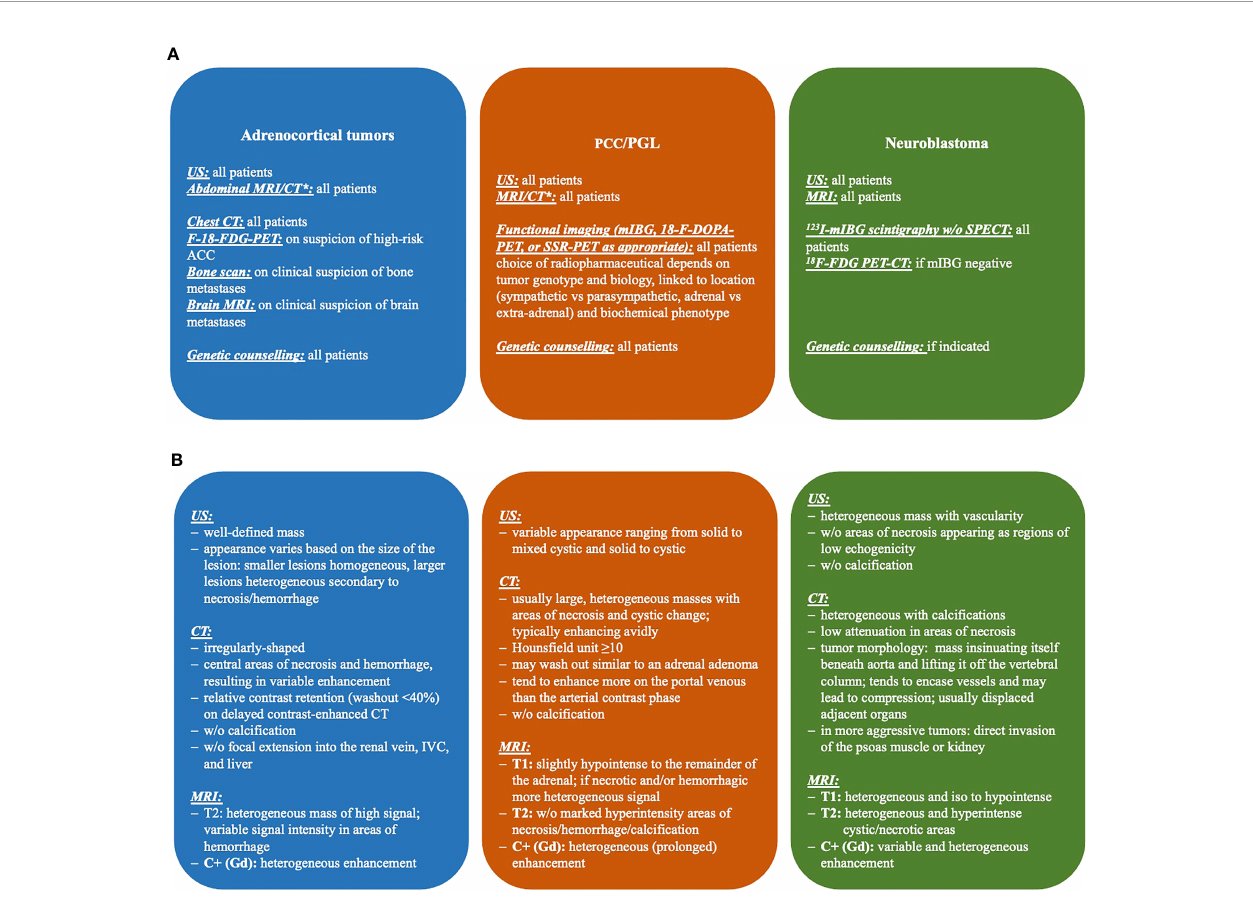
FIGURE 1 | Imaging diagnostics (A) and features (B) of adrenal tumors in children. CT, computed tomography; FDG, fl uorodeoxyglucose; mIBG, metaiodobenzylguanidine; MRI, magnetic resonance imaging; PET, positron emission tomography; SPECT, single-photon emission computed tomography; US, ultrasonography; *, CT in selected cases only due to radiation